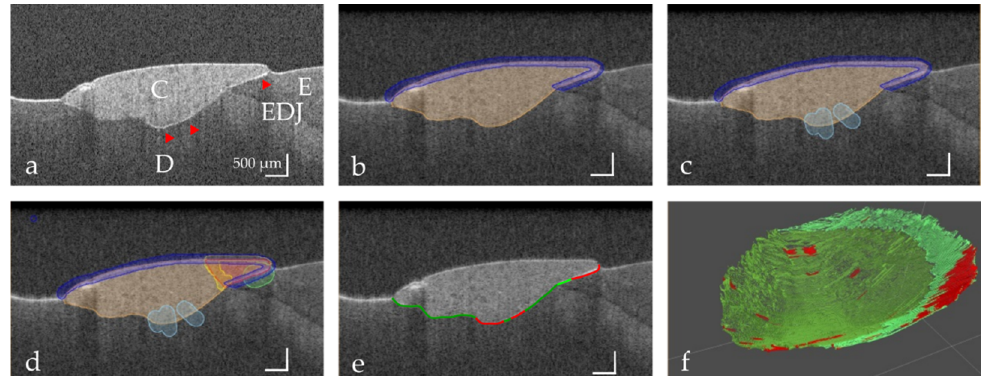
Figure 4. ( a ) An OCT cross-sectional image of tooth 13 restored with FbM/Amaris. In the B-scan enamel (E), dentin (D), composite (C), and the enamel-dentin junction (EDJ) are displayed. Interfacial adhesive defects (bright lines, red arrow heads), the lengths of which can be determined, occur at the interface with both enamel and dentin. ( b ) To consider only the composite–dentin interface (orange line), the composite surface and the composite–enamel interface were segmented (blue line). ( c ) Interfacial adhesive defects at dentin were segmented as light blue areas. ( d ) The interface on enamel and associated gap signals were segmented as described before. ( e ) Result of the semi-automatic segmentation of the B-scan with the intact interfaces on dentin (dark green) and enamel (light green) or interfacial adhesive defects (red). ( f ) 3D display of the tooth–composite interfaces with attachment to dentin (dark green) and enamel (light green), as well as interfacial gap formations (red). Scales refer to refractive index n = 1.0.